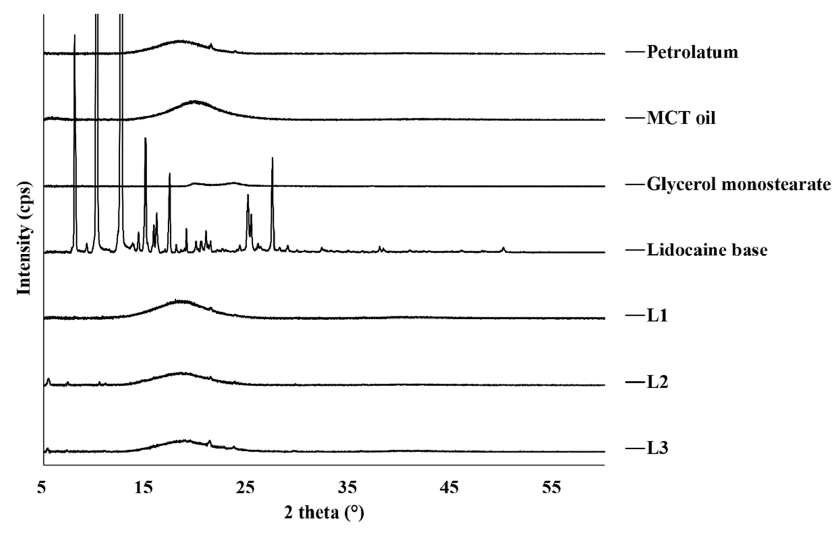
Figure 1. DSC thermograms of raw materials and prepared lidocaine ointments. MCT, medium- chain triglyceride. There was an error in the original article in Figure 2, “Lidcocaine” is misspelled as a legend. The correct Figure 2 appears below.